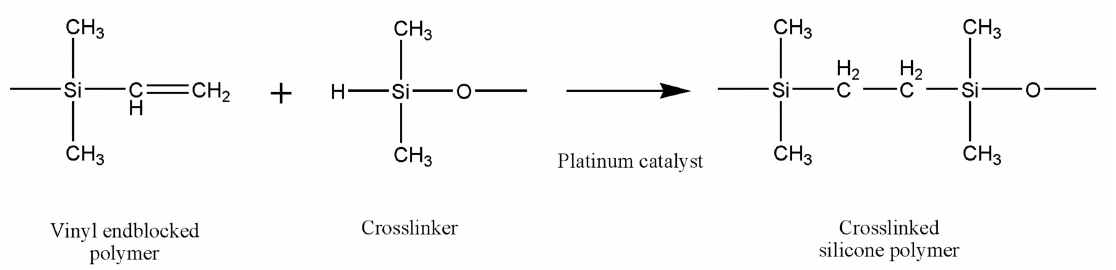
Figure 1. The hydrosilylation reaction of liquid silicone